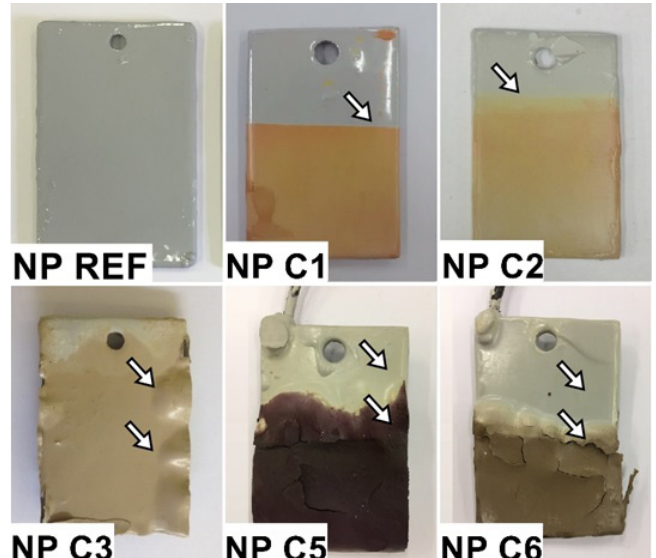
O paint (NP) test specimens after immersion 2 5